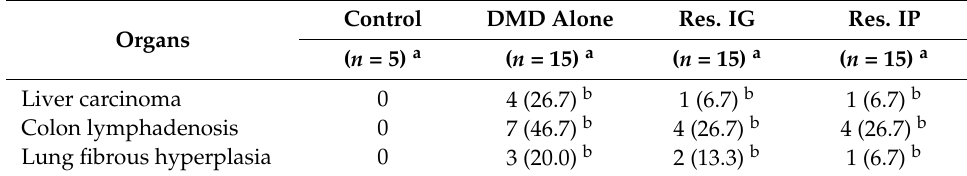
Table 2. Incidences and severity of pathological alterations in three major organs. Control DMD Alone Res. IG Res. IP Organs Liver carcinoma Colon lymphadenosis Lung fibrous hyperplasia a Number of rats; b Percentages in parentheses.